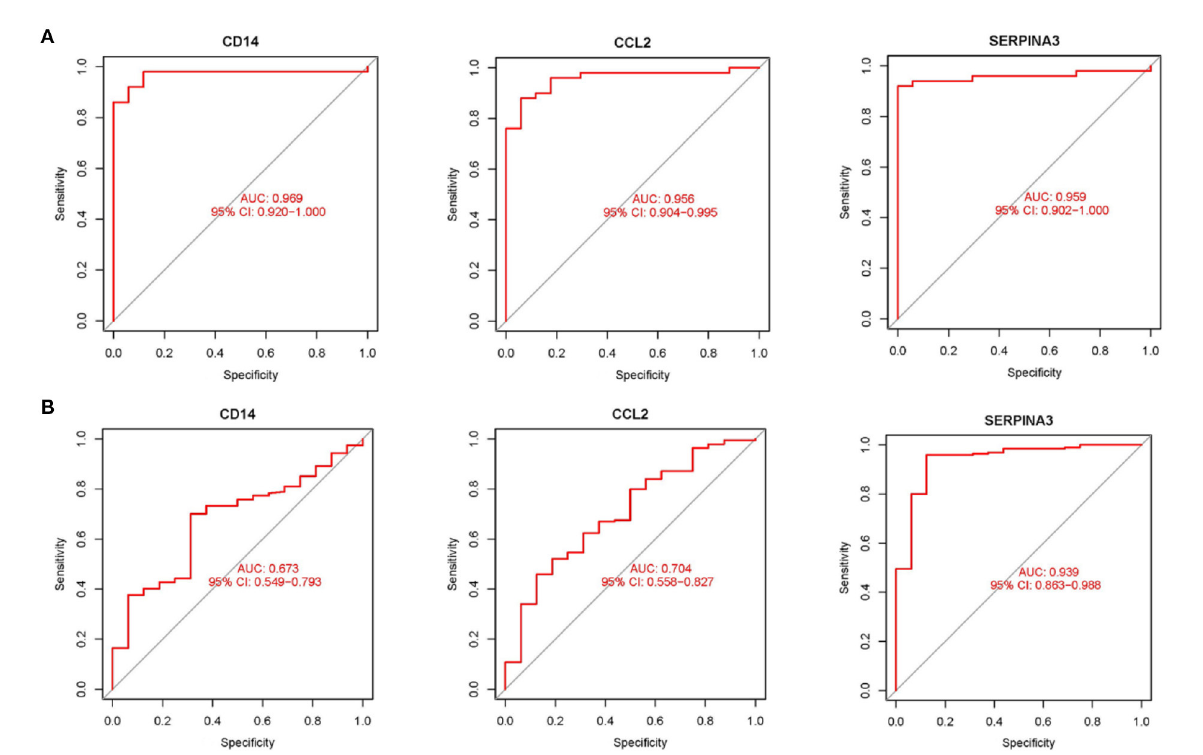
FIGURE5 Validation hub genes are used as marker genes (A) Diagnostic ability of hub genes in the training datasets. The area under ROC curve (AUC) was used to evaluate the discriminating ability of hub gene in cardiomyopathy and control groups. (B) The validation results of hub gene in the large sample validation dataset (GSE5406) were similar to those of the training